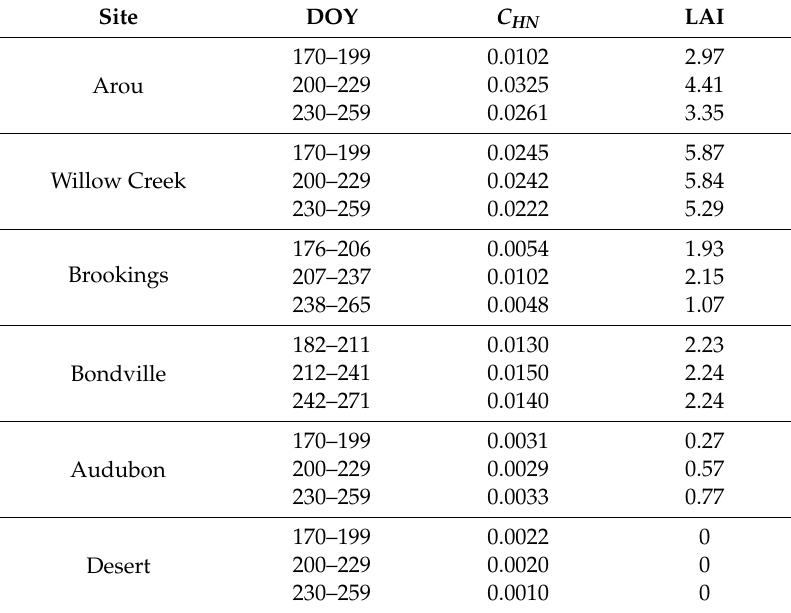
Table 3. Estimated neutral bulk heat transfer coe ffi cient ( C HN ) values by the VDA approach at the six study sites, and corresponding LAI